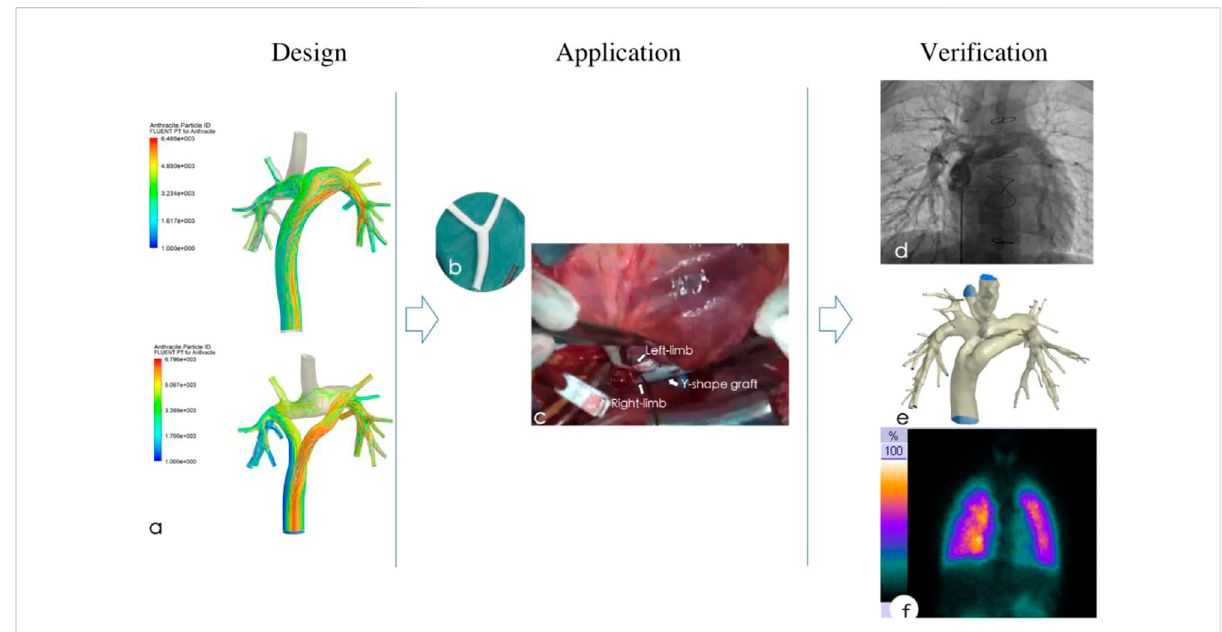
FIGURE 6 Preoperative design based on computational fl uid dynamics simulation (A) , then a handcrafted Y-shaped conduit (B) was applicated for functional single ventricle (C) , postoperative catheter angiography (D) , CT angiography (E) and pulmonary perfusion scan (F) showed normal pulmonary pressure and resistance, while IVC fl ow was distributed